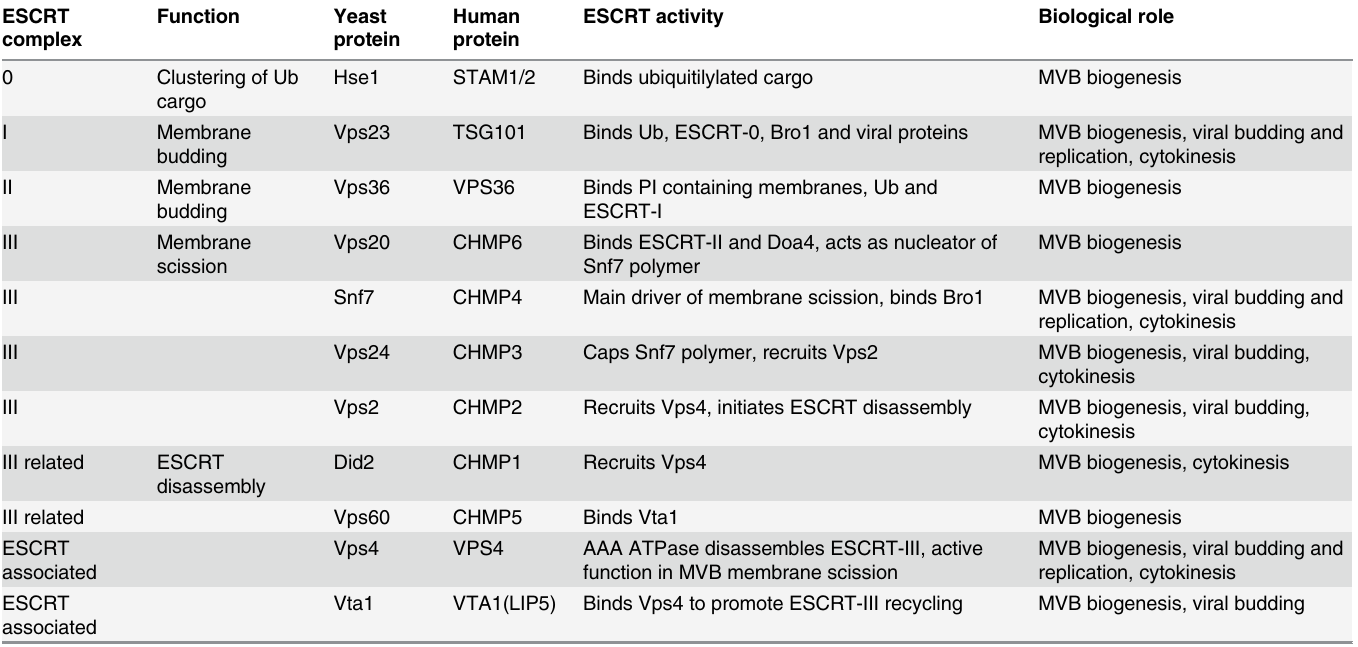
Table 1. ESCRT subunits and associated